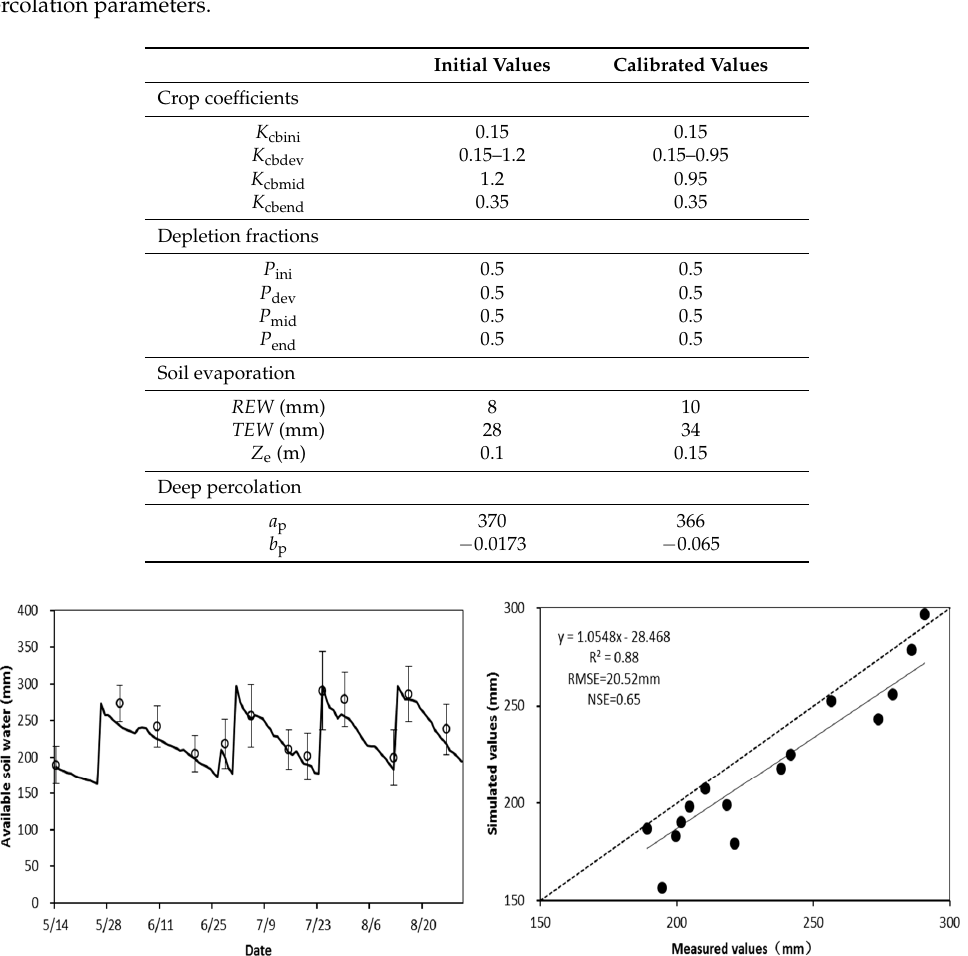
Figure 4. Comparison between simulated and observed available soil water of maize for seed. The results show that the regression coefficient was less than 1.0, indicating that the data plotted slightly below the 1:1 line of the observed data. The coefficient of determination was 0.88, indicating that most of the variance could be explained by the model. The RMSE reached 20.52 mm, representing approximately 6.7% of the total available water ( TAW ). Additionally, the NSE value was 0.65. The statistical test values of determining coefficient, regression coefficient and intercept are 9.98, 0.52, and 1.14, respectively, with t -test ( t 0.05 = 2.131, n = 15). The results suggest that the SIMDualKc model effectively accounted for the variation in the observed ASW and accurately predicted the ASW value of maize for seed. 3.1.2. Validation of the SIMDualKc Model The results of comparing the observed and simulated ET c values are presented in Figure 5. The coefficient of determination was 0.79, indicating that most of the variance could be explained by the model. The RMSE reached 1.01 mm/d, and the NSE value was 0.56. The statistical test values of determining coefficient, regression coefficient and intercept are 15.55, 11.53, and 8.09, respectively, with t -test ( t 0.05 = 1.996, n = 67). The results show that there are some schematic errors in the model that can reducing ET c predictive power. The observed value ET c is the water consumption calculated by the energy balance of the eddy-related system, while the SIMDuaIKc model calculates the ET c based on the water balance formula. Results of previous research indicate that the ET c calculated by the vorticity correlation system is lower than that calculated by the water balance formula [59], the comparison of ET c at different scales may be the main reason of schematic errors. Figure 5. Comparison between the simulated and observed ET c values of maize for seed. 01234 5678910 2012/6/20 2012/7/10 2012/7/30 2012/8/19